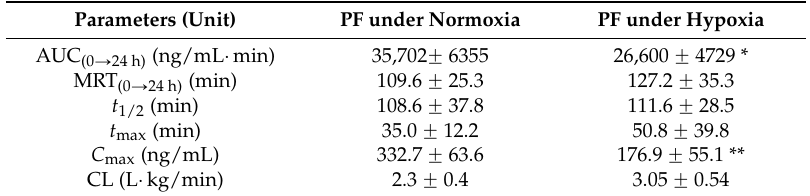
Table 4. The main pharmacokinetic parameters of PF under normoxia/hypoxia in rat plasma after a single intragastrical administration ( n = 6).